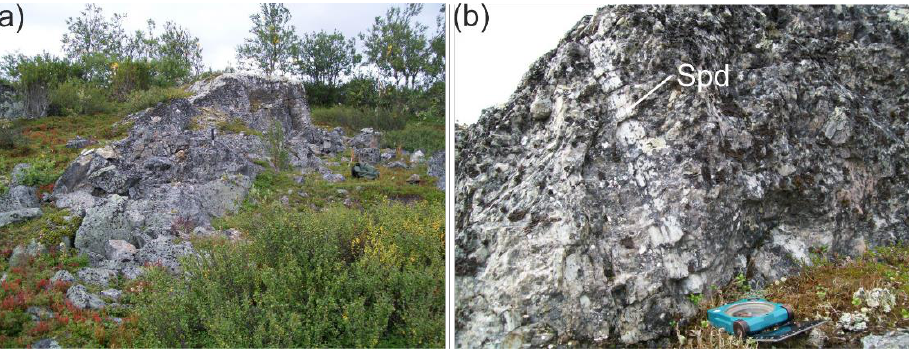
Figure 3. ( a ) Exposure of an albite-spodumene pegmatites dyke of the Kolmozero deposit. ( b ) Spodumene (Spd) crystals in an albite-spodumene pegmatites of the Kolmozero